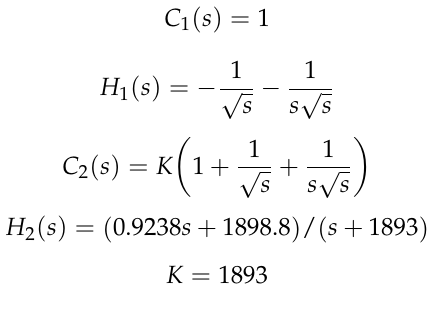
Figure 23. Impact of Noise and Uncertainty (Technique 4).